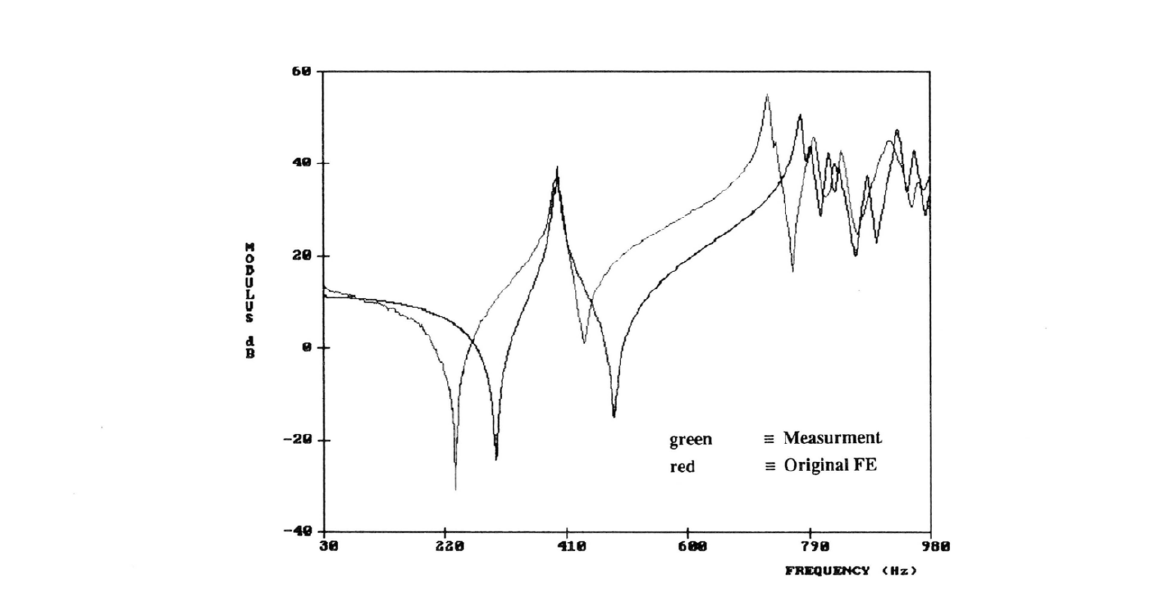
1. companson of natural frequencies In Table 5; 2. MAC plot in Fig. 8; and 3. FRF overlays in Fig. 9.